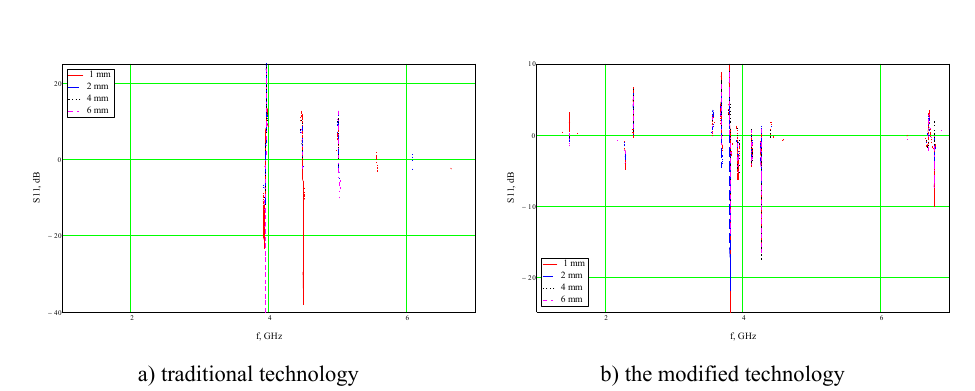
Fig. 3. The illustration parameter dependence on used technology of 11 S